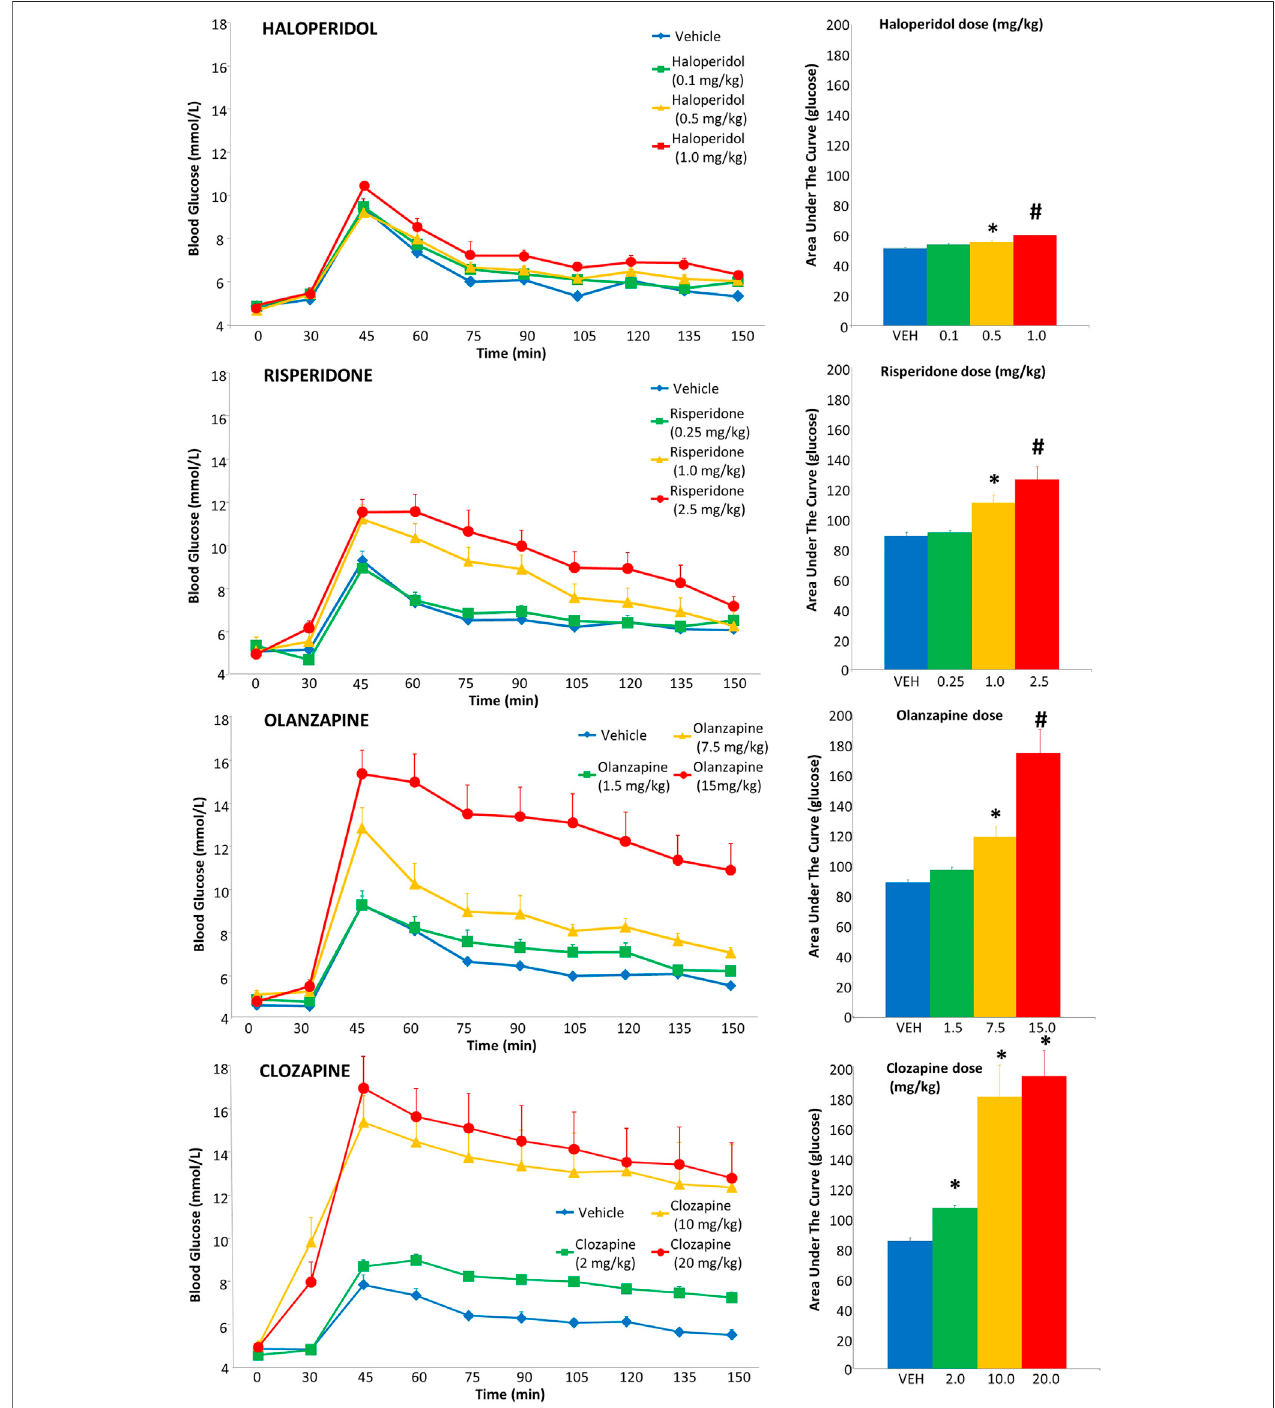
FIGURE 2 | Acute effects of antipsychotics drugs on glucose levels in adult female rats. Animals ( n = 10 – 11 per group) received a single injection of vehicle or haloperidol (.1, .5, 1.0 mg/kg, s.c), risperidone (.25, 1.0, 2.5 mg/kg, s.c), olanzapine (1.5, 7.5, 15.0 mg/kg, s.c) or clozapine (2.0, 10.0, 20.0 mg/kg, s.c). Glucose levels were recorded prior to drug treatment in overnight-fasted rats at time = 0, and then 30 min following drug administration ( x -axis). Immediately following this glucose measurement, all rats were subjected to a glucose tolerance test by receiving an intraperitoneal challenge injection of 1 mg/ml/kg of glucose, and blood glucose levels were measured every 15 min for the next 2 hours. Total cumulative glucose levels for each treatment group are summed as the “ area under the curve ” during the glucosetolerancetest totheright. Values represent group means±SEM. * statistically signi fi cantdifference compared tovehiclegroup, p < .05; #statistically signi fi cant difference compared to all other groups, p <